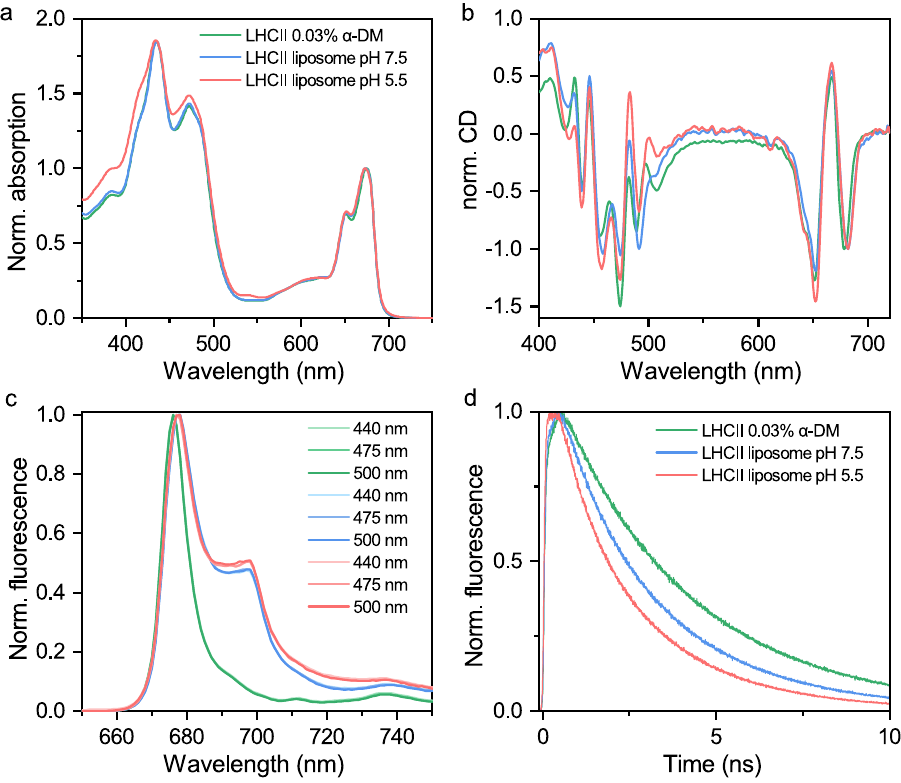
Figure 2. Spectral characteristics of LHCII in detergent (at pH 7.5) compared to LHCII reconstituted into liposomes at pH 7.5 or pH 5.5. ( a ) Absorption spectra normalized to the Q y maximum ( b ) circular dichroism spectra normalized to the negative ~ 680 nm peak ( c ) 77 K emission spectra with excitation wavelengths of 440 nm, 475 nm and 500 nm, normalized to the maximum ( d ) fluorescence decay traces upon excitation at 468 nm and detection at 680 nm. Proteoliposome preparations had lipid:protein molar ratios of 133:1. Results are representative of three independent experiments with similar